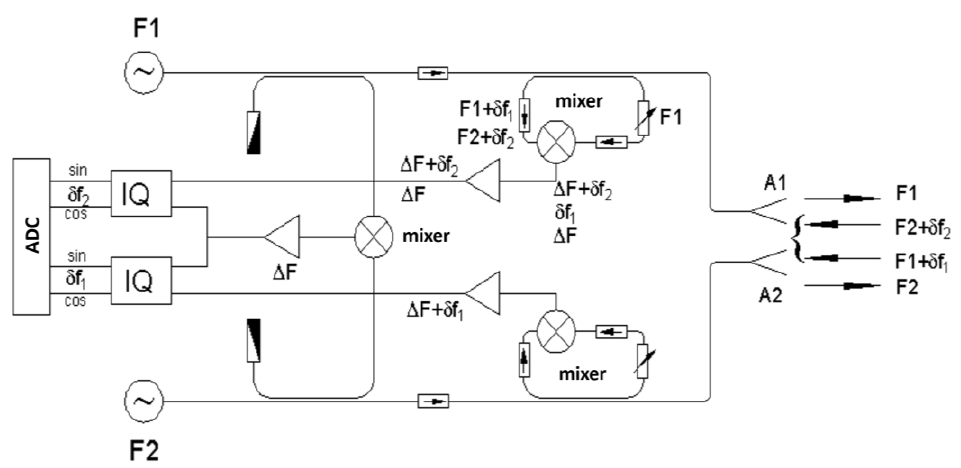
Figure 4. Schematic of Doppler reflectometry system in TUMAN-3M.